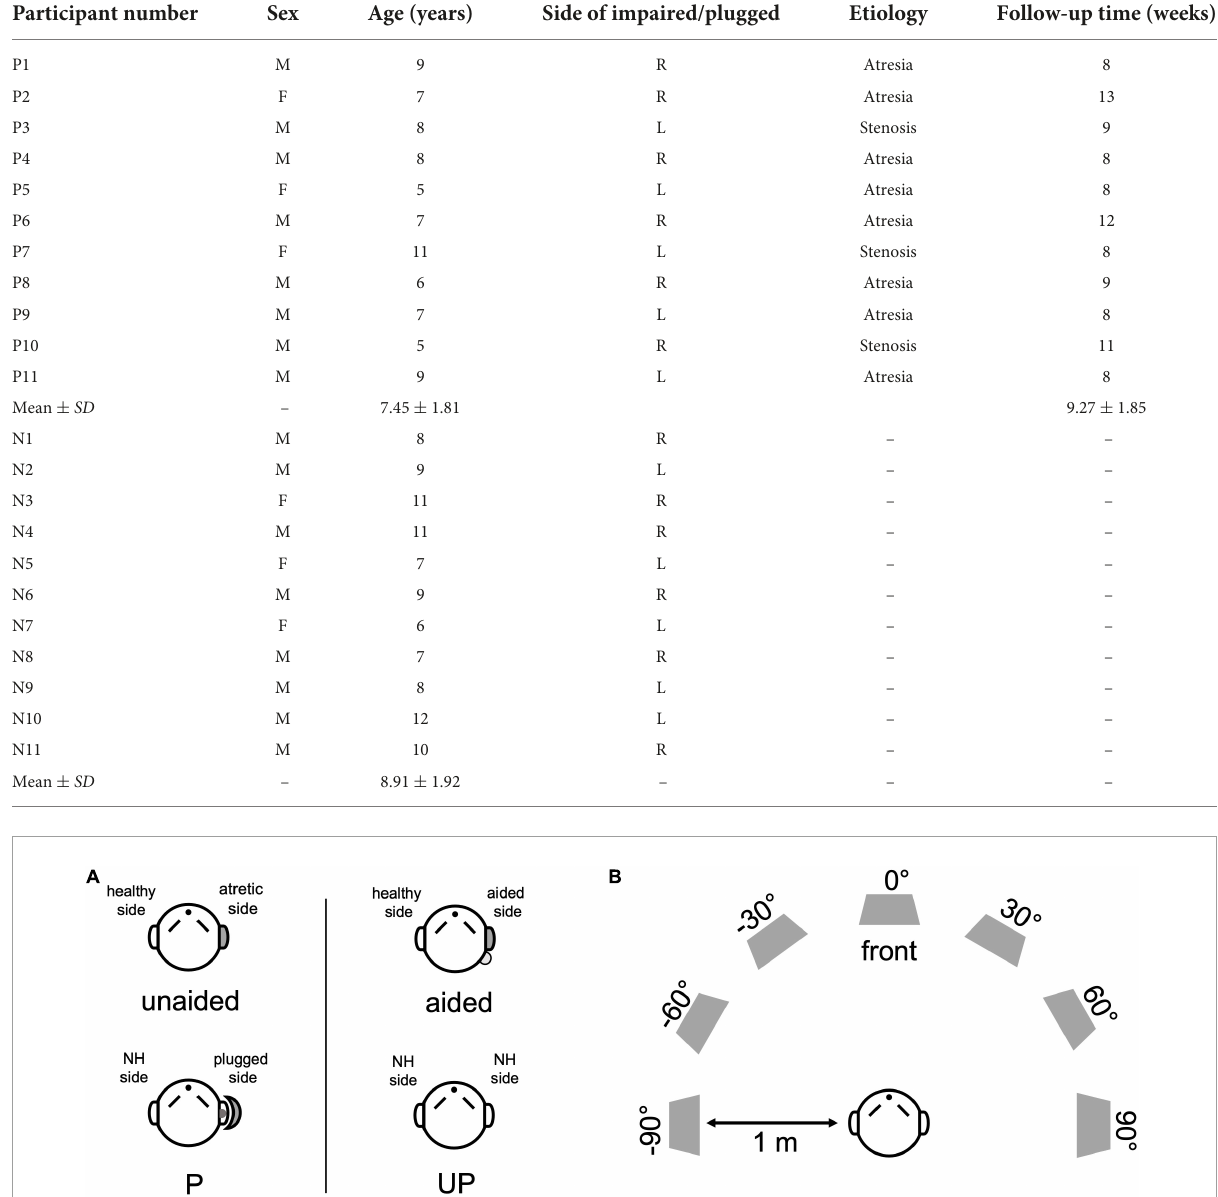
TABLE 1 The demographic data of 11 patients with UMA and 11 children with NH.